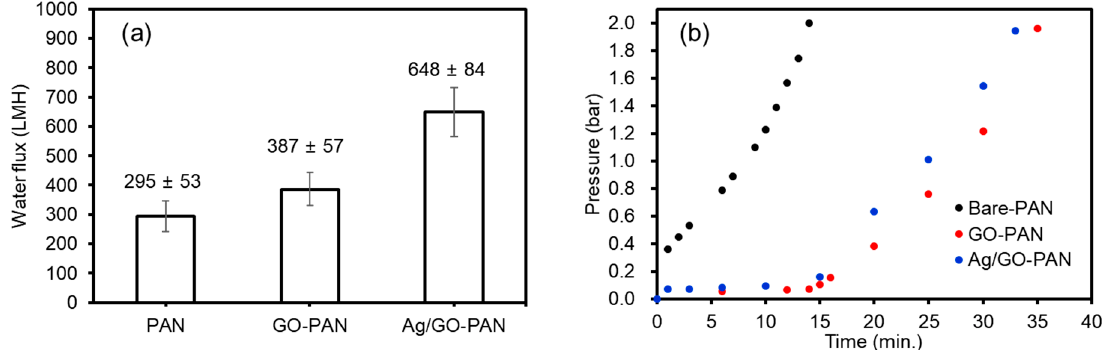
Figure 5. ( a ) Purewater permeability and ( b ) trans membrane pressure (TMP) of the nanofiber membrane. (Note; the TMP was tested with harsh wastewater).